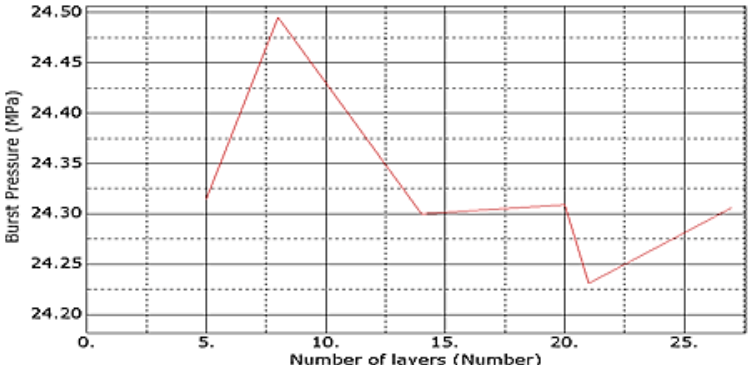
Figure 14. Effects of an increasing number of layers on burst pressure.